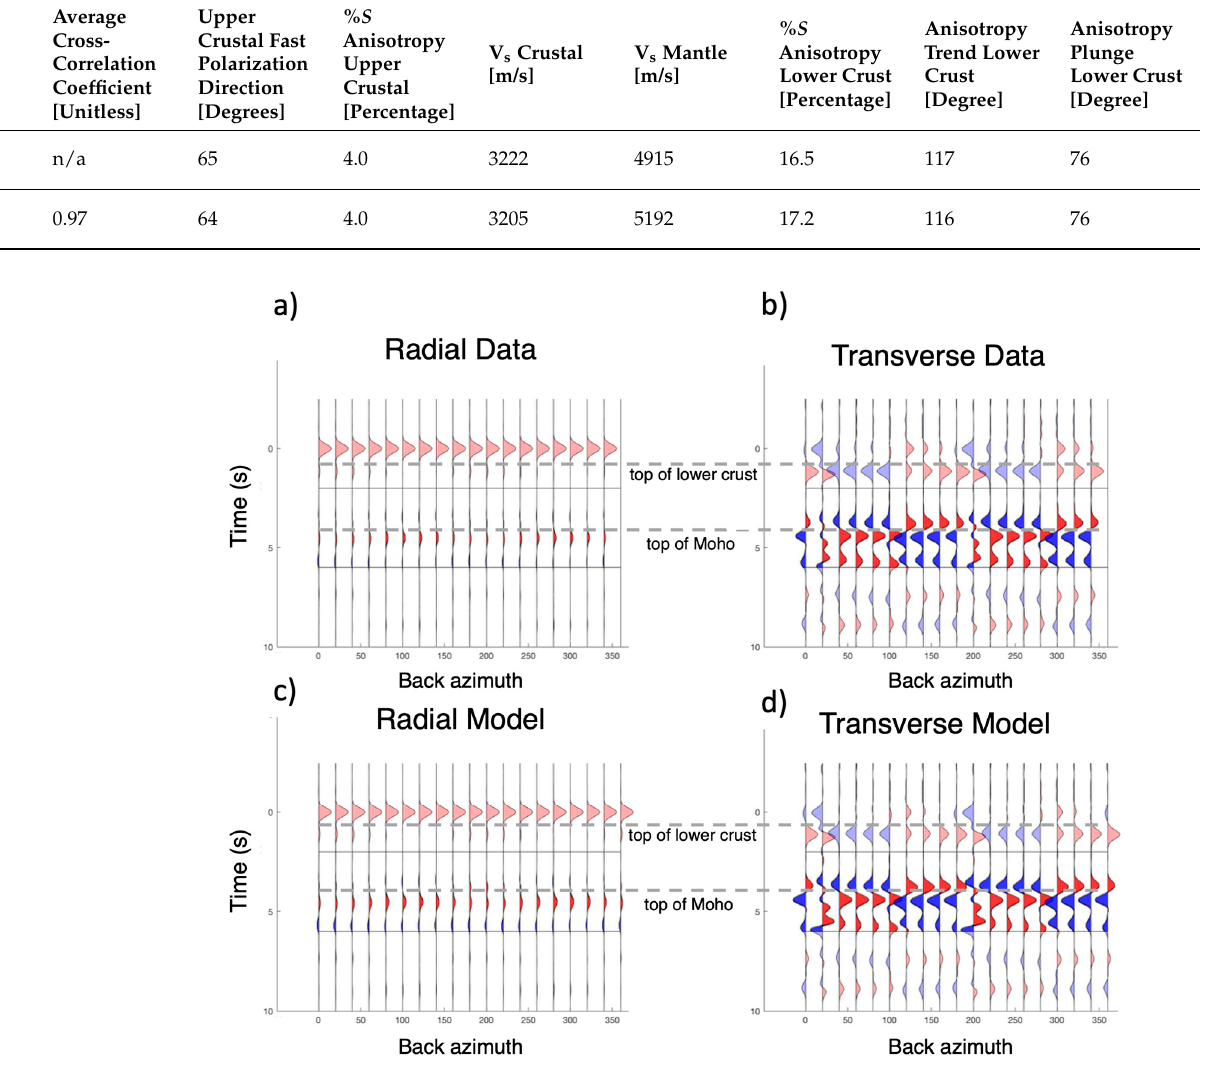
Figure 4. The radial and transverse receiver functions, binned by back azimuth, created from the synthetic model ( a , b ) and by the best-fitting model in the inversion ( c , d ); ( a , b ) the radial and transverse synthetic data. ( c , d ) the radial and transverse receiver functions from the best-fitting model. The solid, horizontal black lines indicate the four second Ps window, and the dashed horizontal gray lines are the interpretation of the top of the lower crust and the Moho. The average zero-lag cross-correlation coefficient between corresponding traces is 0.99. The 0° and the 360° traces are identical; data are only displayed in the 360° trace after the inversion.